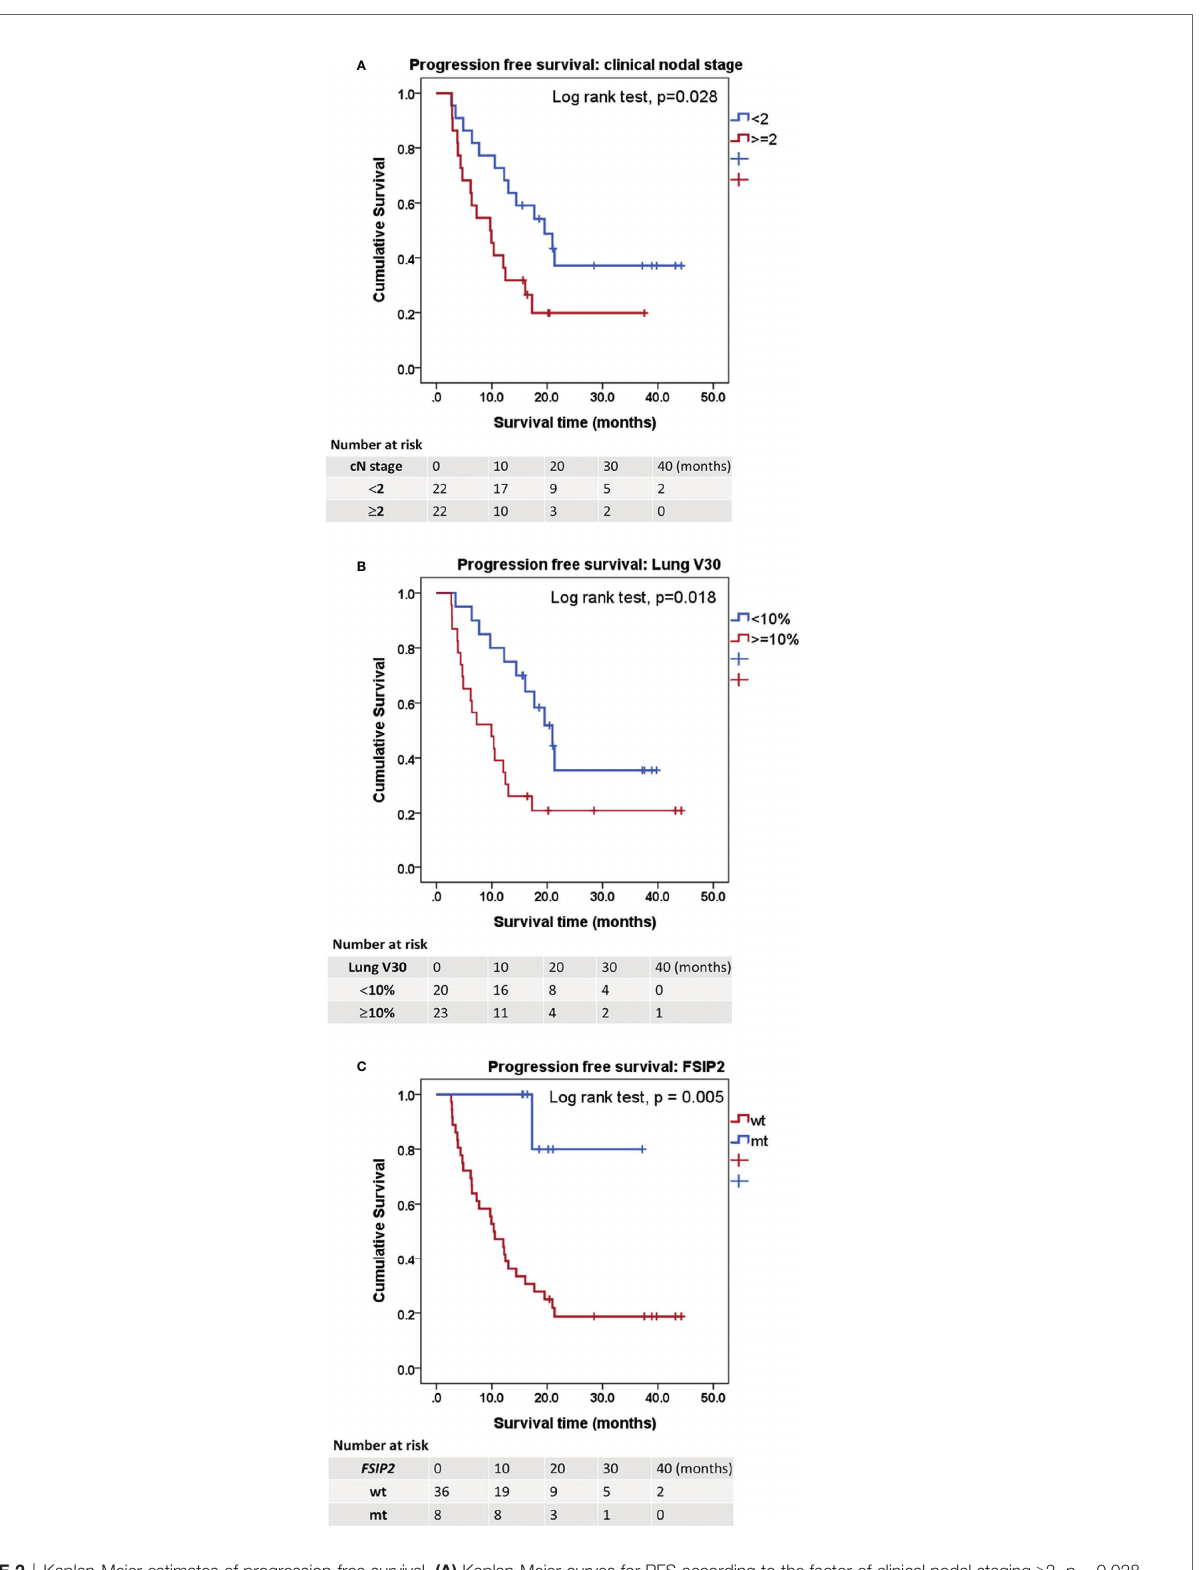
FIGURE 2 | Kaplan-Meier estimates of progression-free survival. (A) Kaplan-Meier curves for PFS according to the factor of clinical nodal staging ≥ 2. p = 0.028. (B) PFS according to the factor of ≥ 10% lung volume receiving ≥ 30 Gy (V30). p = 0.018. (C) PFS according to the mutation of fi brous sheath interacting protein 2 (FSIP2). p = 0.005. Statistical signi fi cance was determined by Log rank test. PFS, progression free